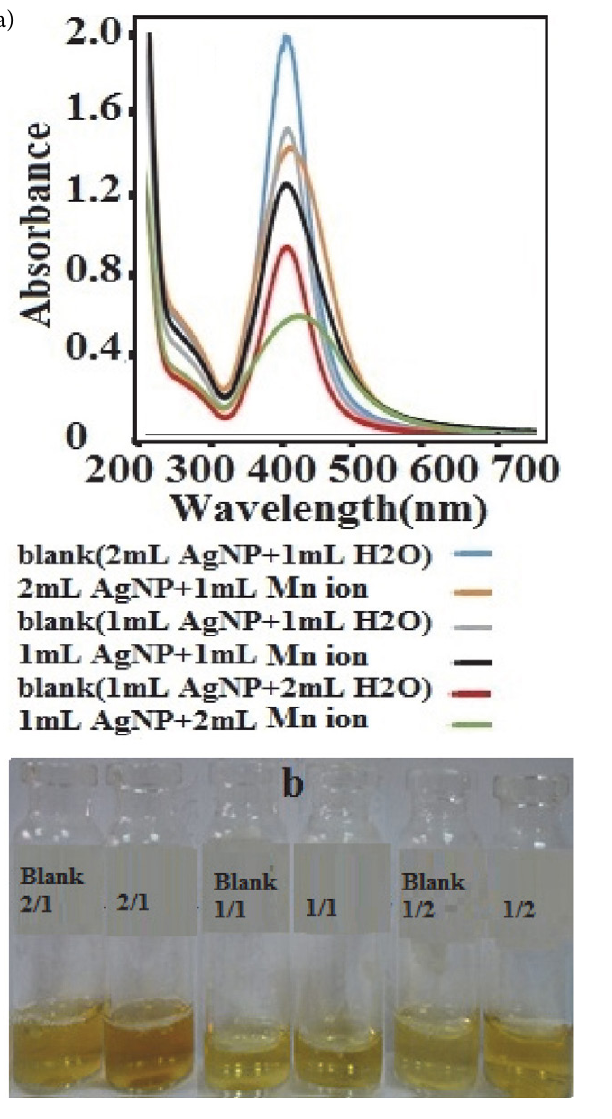
Figure 9. The UV–vis spectra and the photographic images of 2:1, 1:1, and 1:2 volume ratio of (a and b) SDS-AgNPs solutions to Mn 2+ ions solution and (c and d) SDS-CD-AgNPs solutions to Cr 2+ ions